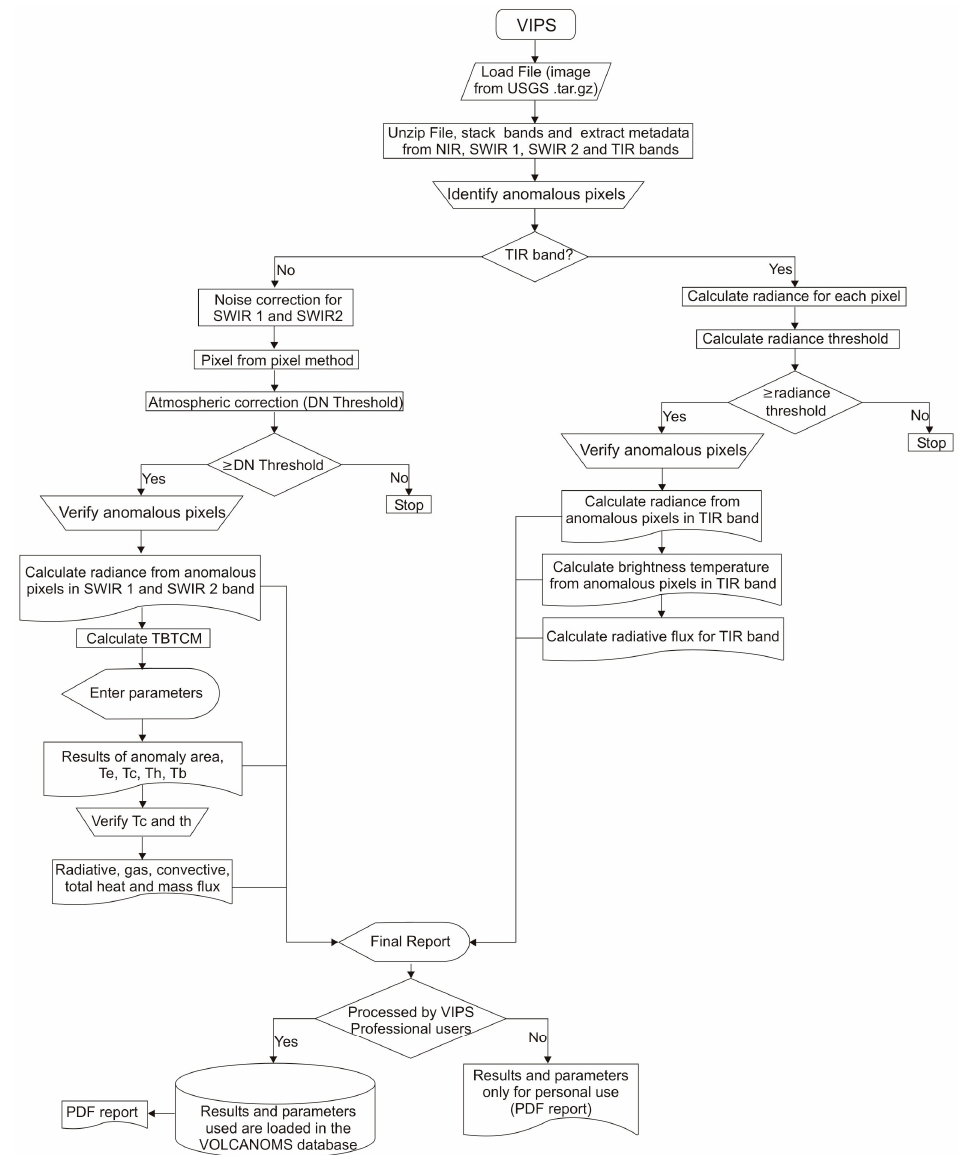
Figure 2. Flow diagram illustrating the mathematical and computing routines of the Volcanic Imagery Processing System (VIPS) software.